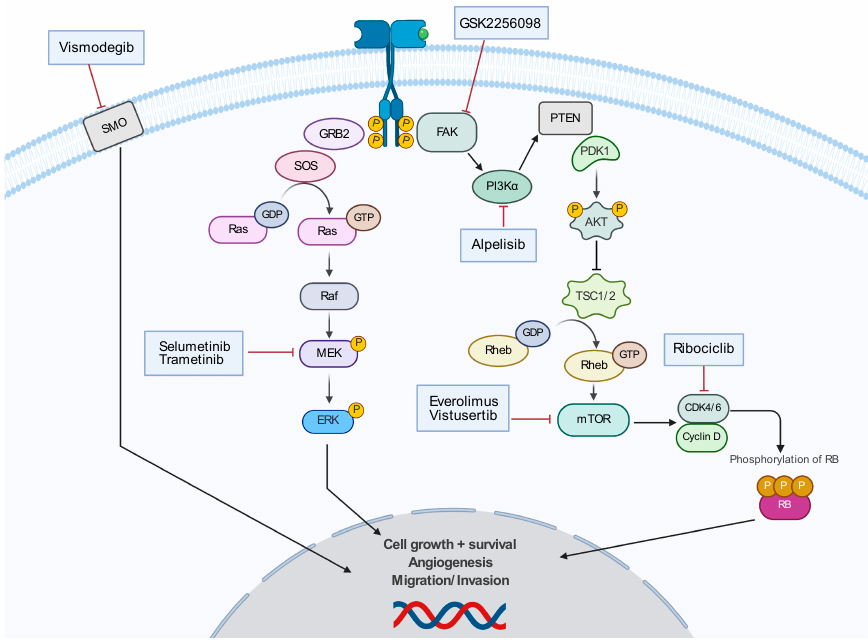
Figure 4. Summary of developing chemotherapy treatments.